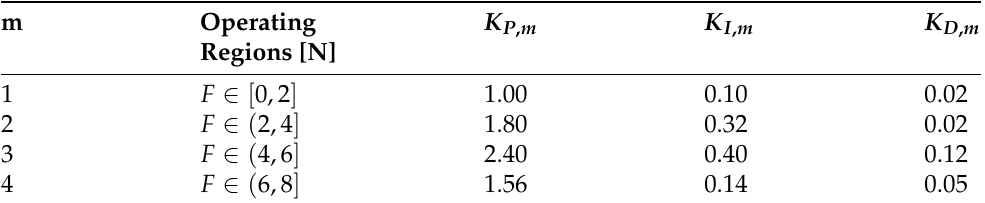
Table 5. PID parameters for the Prototype (A) Closed-Loop control